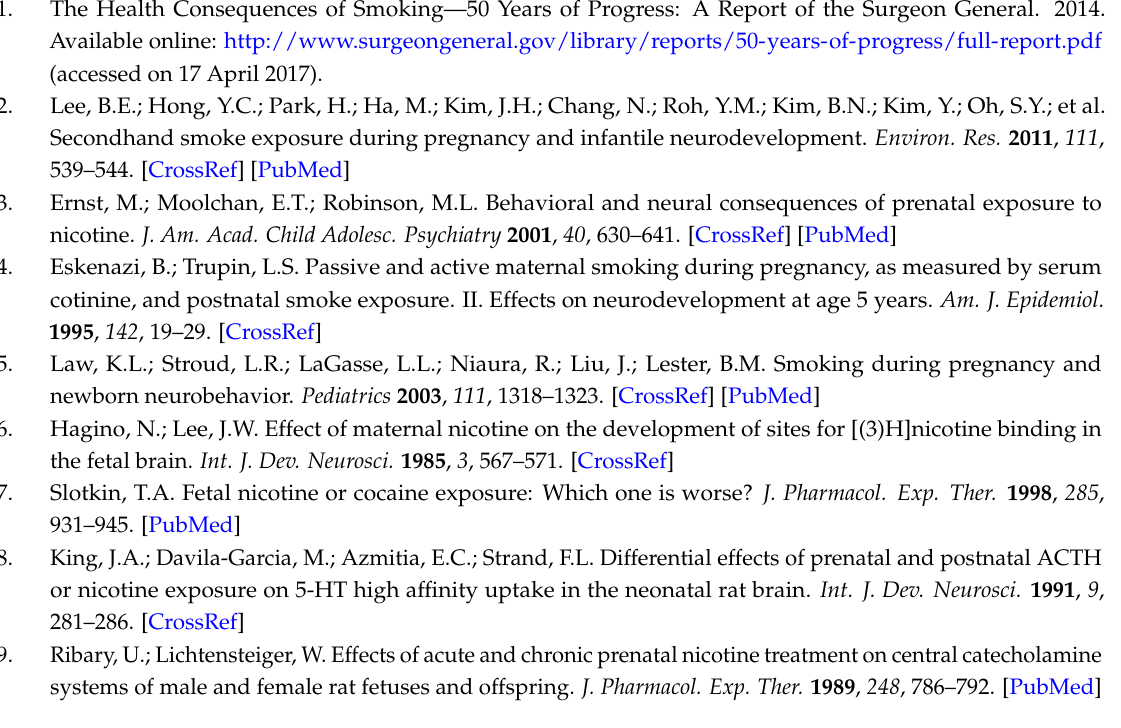
Table S1: Child and parental characteristics; Table S2: Characteristics of exposure and outcome variables; Table S3: ETS exposure during pregnancy based on selected indicators and psychomotor development at one and two years. Multiple linear regression model; Table S4: Socio-economic status: Low/Medium. ETS exposure during pregnancy based on the cotinine level in saliva and child psychomotor development at one and two years of age. Multiple linear regression model; Table S5: Socio-economic status: High. ETS exposure during pregnancy based on the cotinine level in saliva and child psychomotor development at one and two years of age. Multiple linear regression